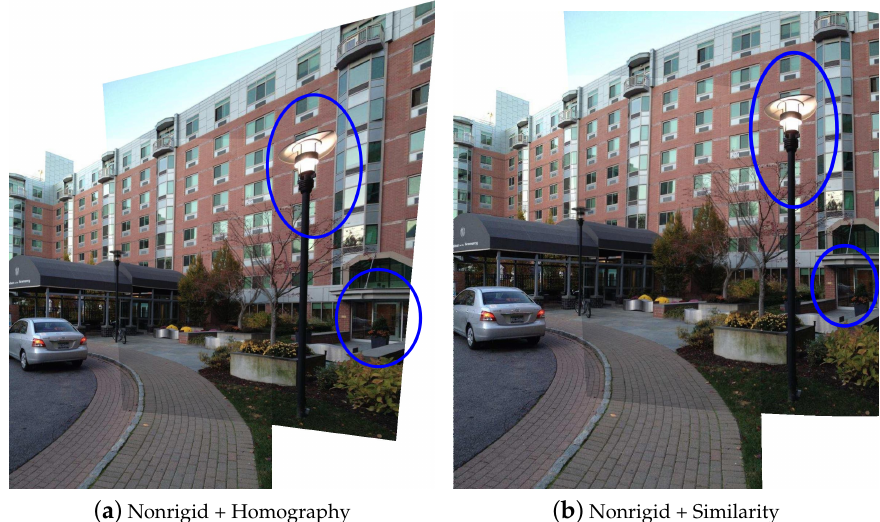
Figure 3. Combination with different global models. The visual effect of homography warp is not as good as similarity warp, because the streetlight and door in nonoverlapping region are severely